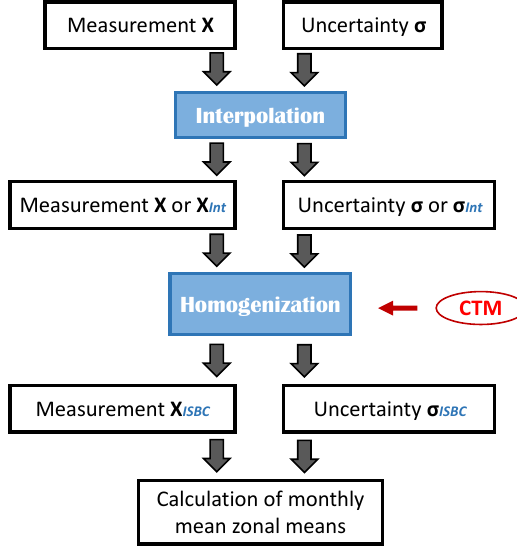
Figure 2. Flow chart describing the different modification and ad- justment steps that are applied to the ozone measurements before they are used in the monthly mean zonal mean calculation. Note that ISBC refers to the inter-satellite bias correction, which is de- scribed in Sect.